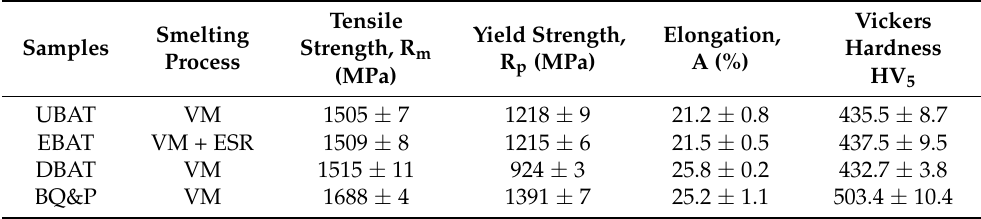
Table 1. Mechanical properties of the four bainitic steel specimens treated by different melting and heat treatment processes.